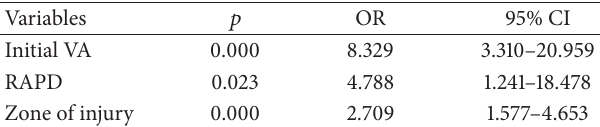
Table4:Multiplelogisticregressionanalysisoffactorswhichmostly affected final visual